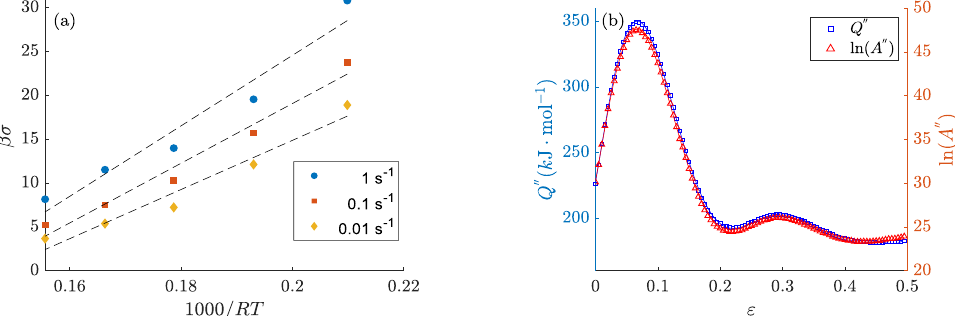
Figure A3. ( a ) The linear plots used for estimating the activation energy and the proportionality constant for the exponential model. ( b ) The obtained ˙ ε -averaged Q (cid:48)(cid:48) and ln ( A (cid:48)(cid:48) )